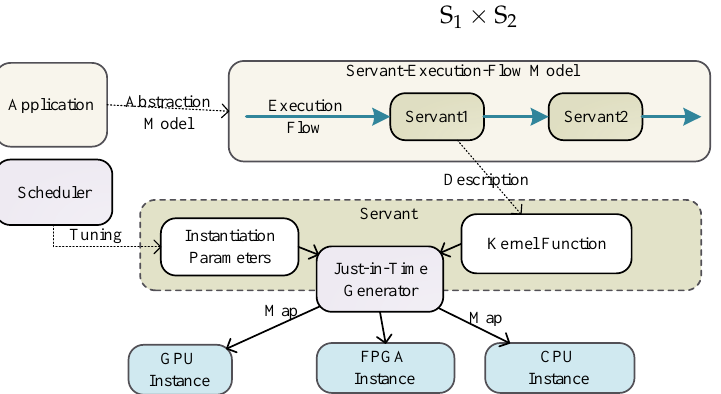
Figure 2. Workflow of FLIA. FLIA abstracts an application and maps servants to heterogeneous computing hardware.